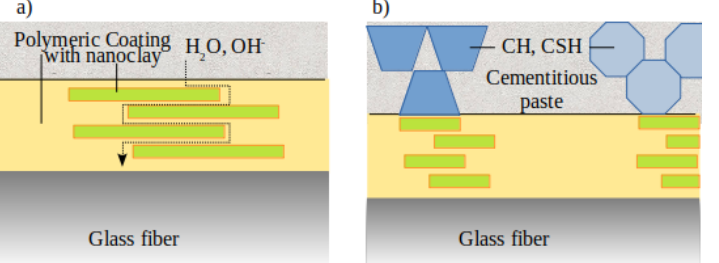
Figure 1. ( a ) Structure of a silicate layered coating on the surface of glass fibers and its barrier properties according to Gao et al. [46]; ( b ) nanoclay particles dispersed in the coating promoting the formation of hydration products at the fiber-matrix